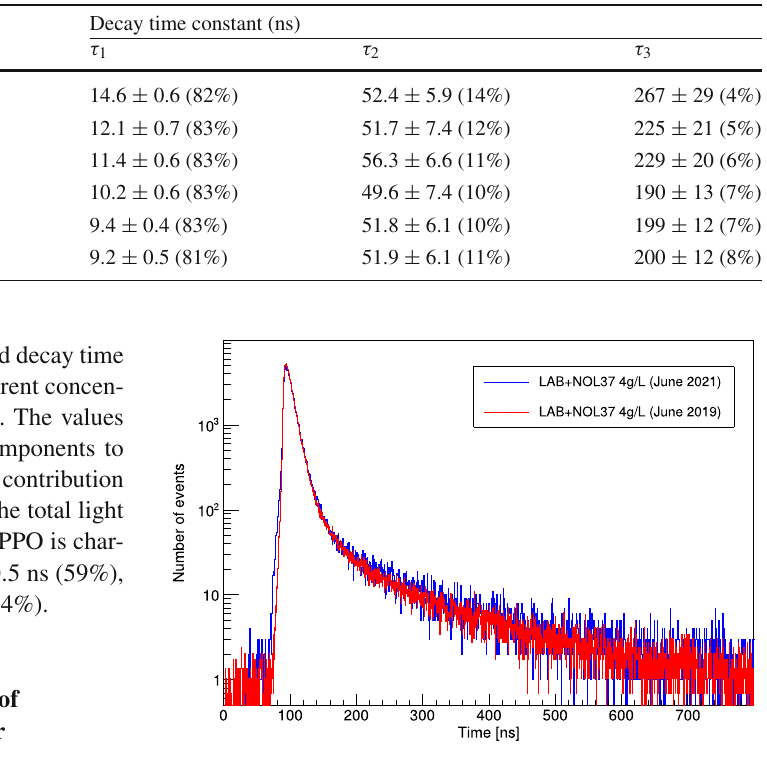
Fig. 8 Light emission kinetics of LAB-based scintillator with NOL 37 measured in June 2019 ( red colour) and June 2021 (blue